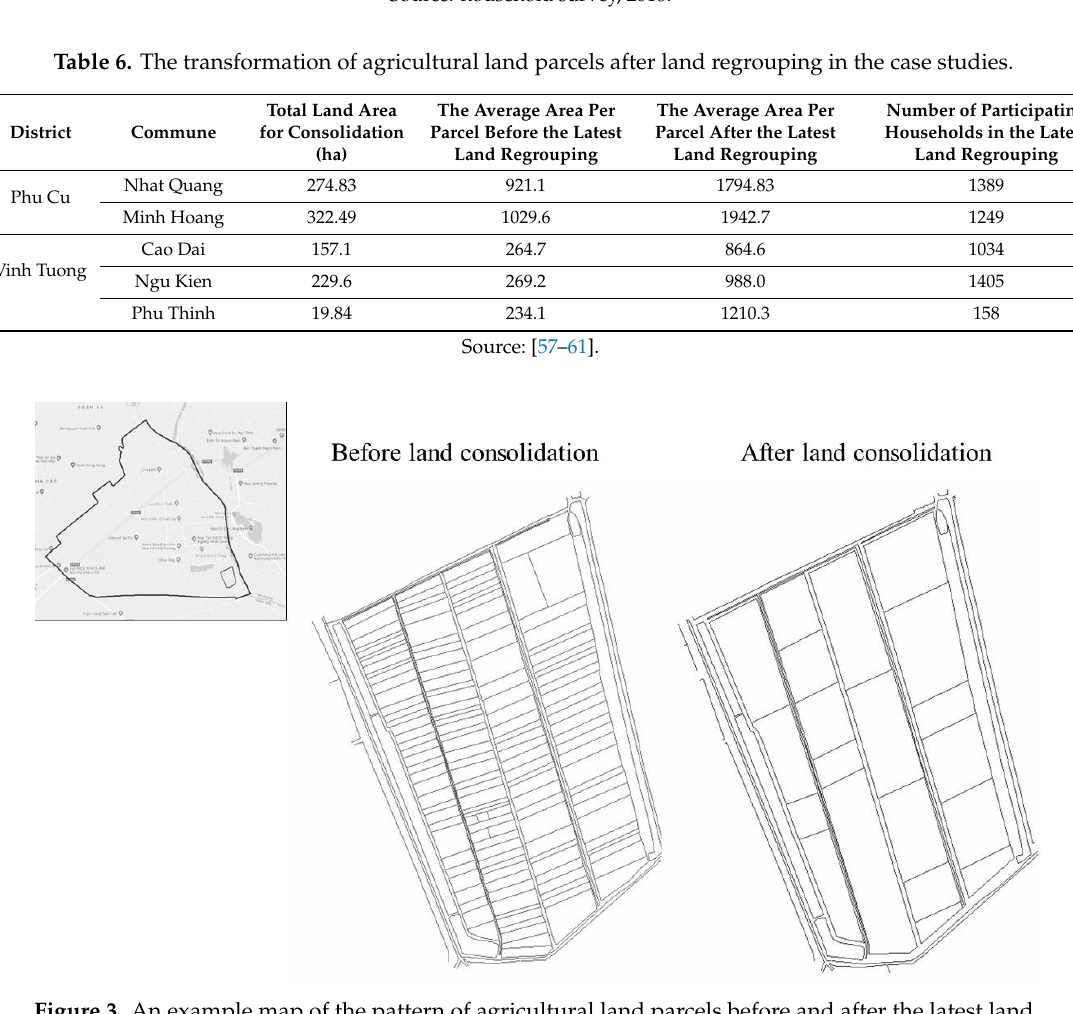
Table 6. The transformation of agricultural land parcels after land regrouping in the case studies.